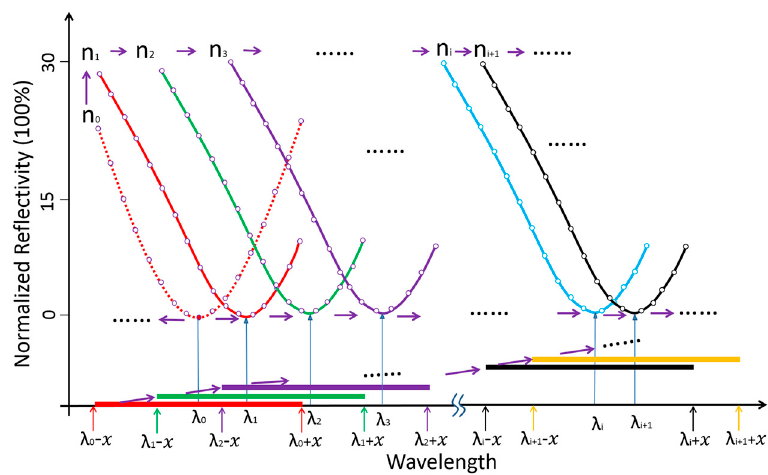
Figure 1. Schematic of tracking the SPR dip based on the feedback loop technique. Here n 0 , n 1 , . . . , n i and n i +1 represent a series of refractive index values at the Au/sample interface when a molecular binding reaction occurs on the sensor surface. As the refractive index changes continuously from n 0 to n i , the spectral range to be scanned is guided by the feedback loop and automatically adjusted from the original spectral range [ λ 0 − x , λ 0 + x ] to [ λ i − x , λ i + x ]. This way, only a selected range around the resonance dip will be interrogated at any time, thereby drastically shortening the time necessary to calculate the location of the SPR dip.